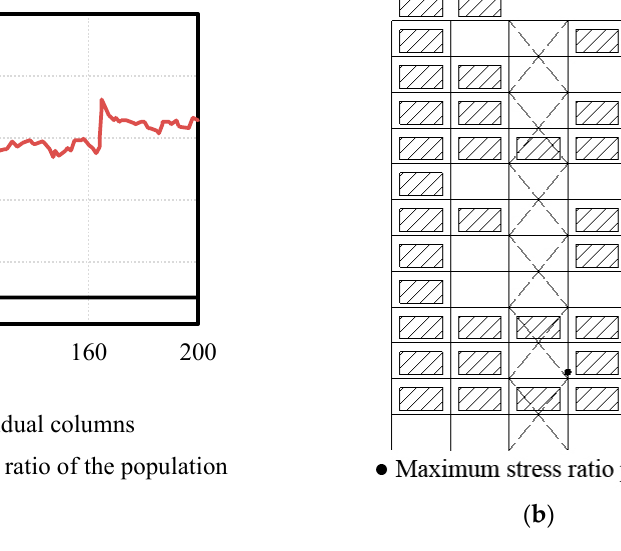
Figure 10. The most favorable distribution of load under 70% full load. ( a ) Tracking chart of optimization performance of GA. ( b ) The most favorable distribution of load (H = 6.24, P = 0.05).